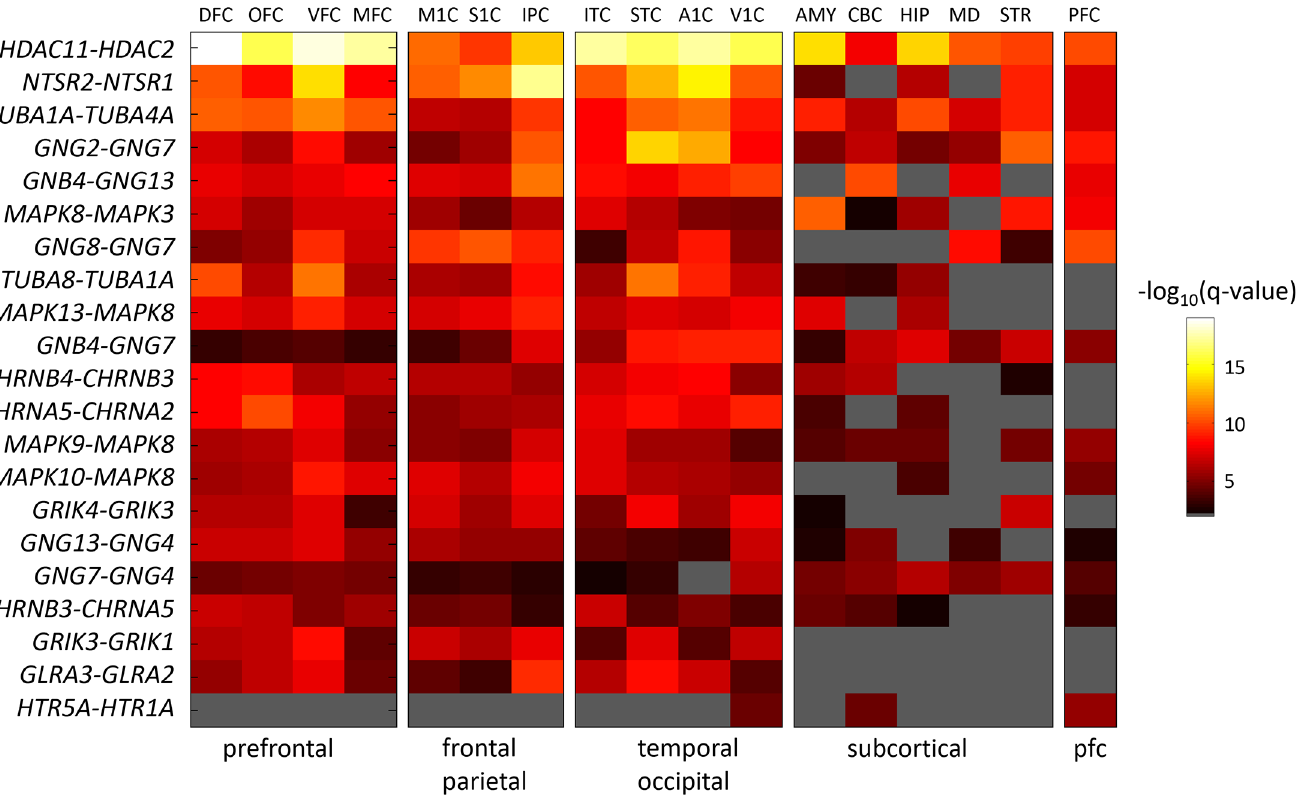
Fig 2. Dissimilarity significance of the top 20 genes in 17 brain regions measured by Kang et al . [32] and in the prefrontal cortex measured by Colantouni et al . [33]. Colors correspond to negative log 10 ( p -values) of Pearson correlation. Gray pixels denote regions in which the range of expression levels (maximum-minimum) was below 1.5 for at least one gene, or an insignificant q-value . The bottom row shows dissimilarity for an interesting pair of serotonin receptors. Brain regions are grouped and sorted as follows: prefrontal: DFC, OFC, VFC, MFC; frontal-parietal: M1C, S1C, IPC; temporal-occipital: ITC, STC, A1C, V1C; subcortical: AMY, CBC, HIP, MD, STR; prefrontal data from [33]: PFC. Region codes are listed in the Methods section. The genes coding for histone deacetylase, HDAC2 and HDAC11 exhibit significant dissimilarity levels in all brain areas. The genes coding for Neurotensin receptor NTSR1 and NTSR2 exhibit significant dissimilarity mainly in cortical regions and the